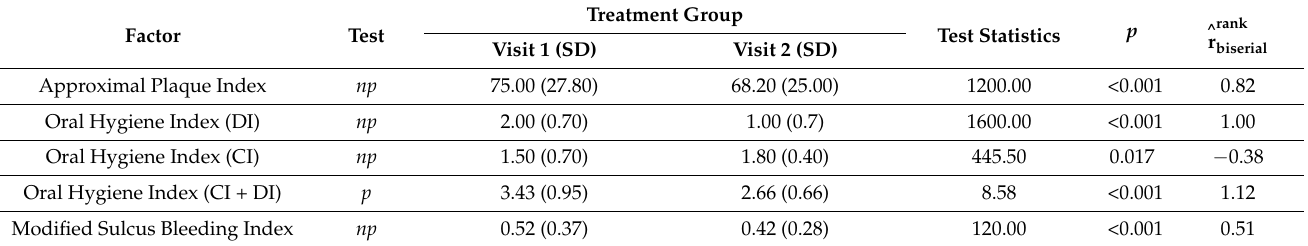
Table 3. Estimating the significance of differences in means for two dependent samples ( n = 57).